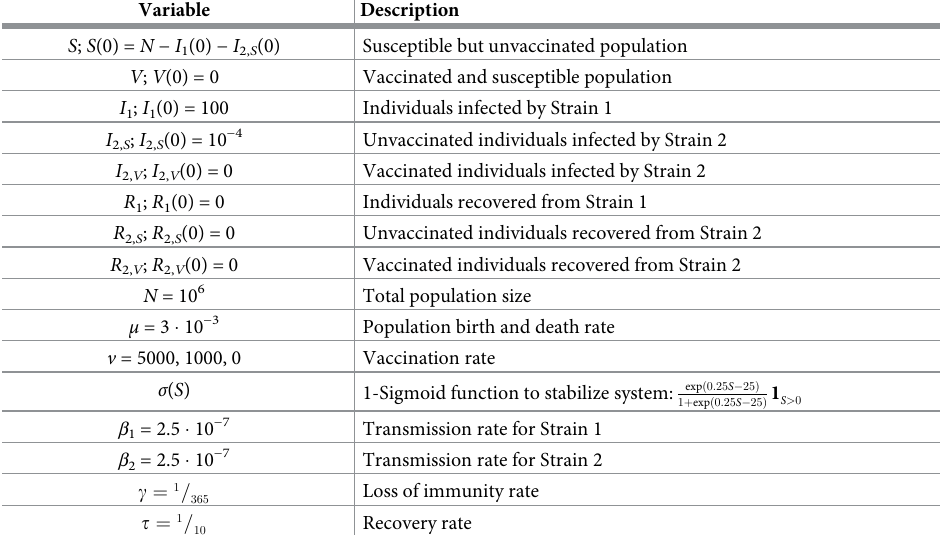
Table 2. Two-strain SIRS model variables and parameters used in simulations.